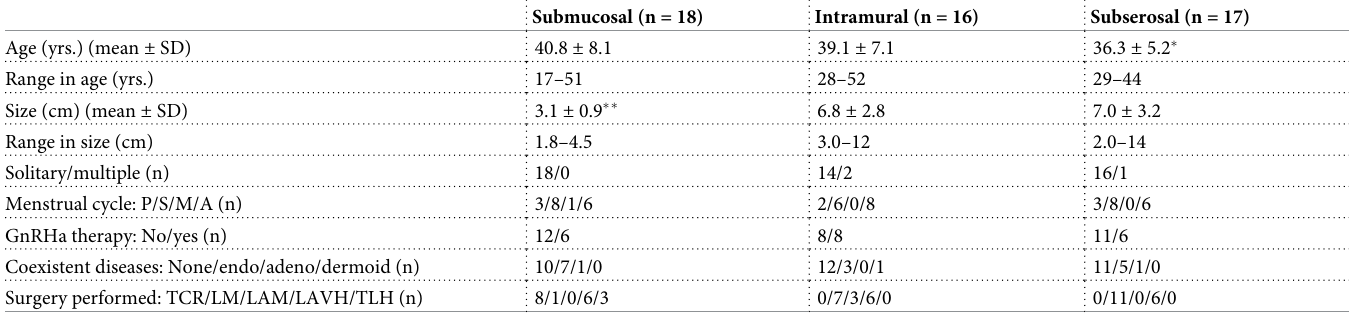
Table 1. Clinical profiles of women with different uterine